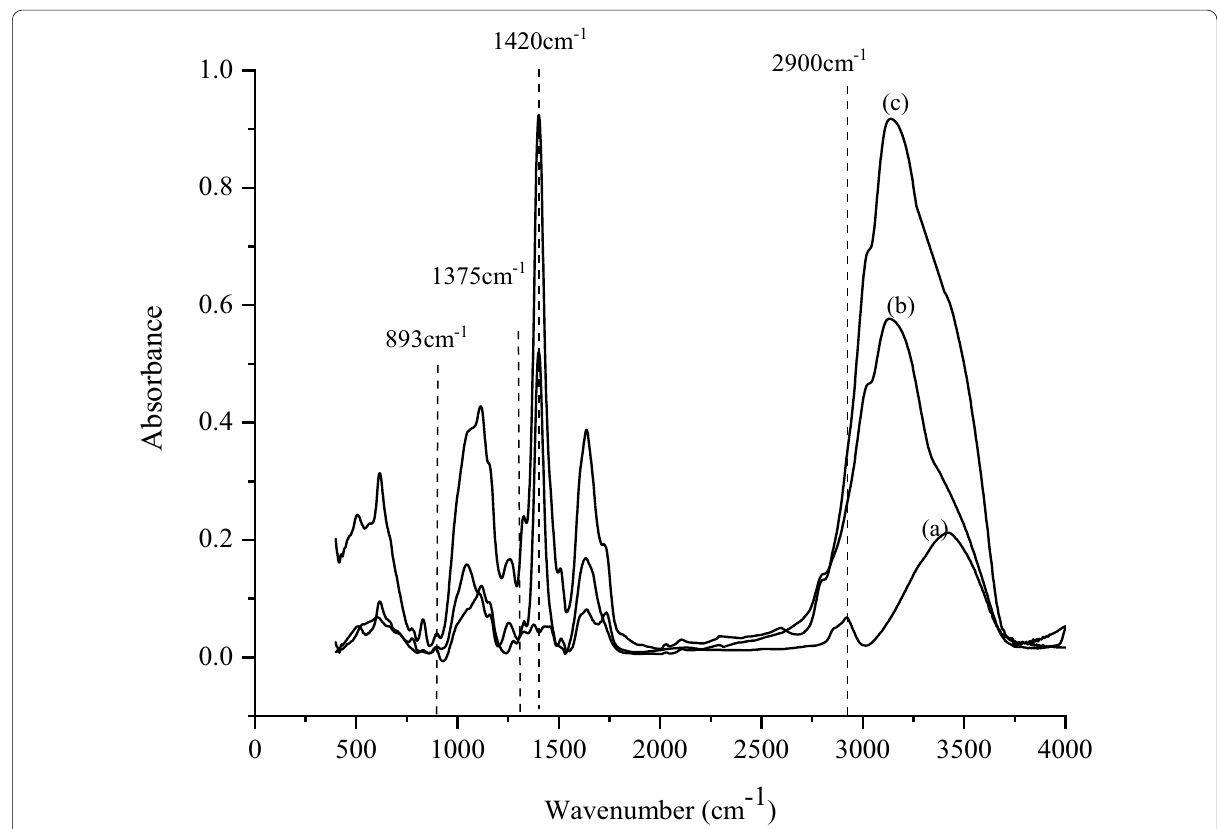
Fig. 7 FT-IR spectra of A raw bagasse B nanocellulose from laccase